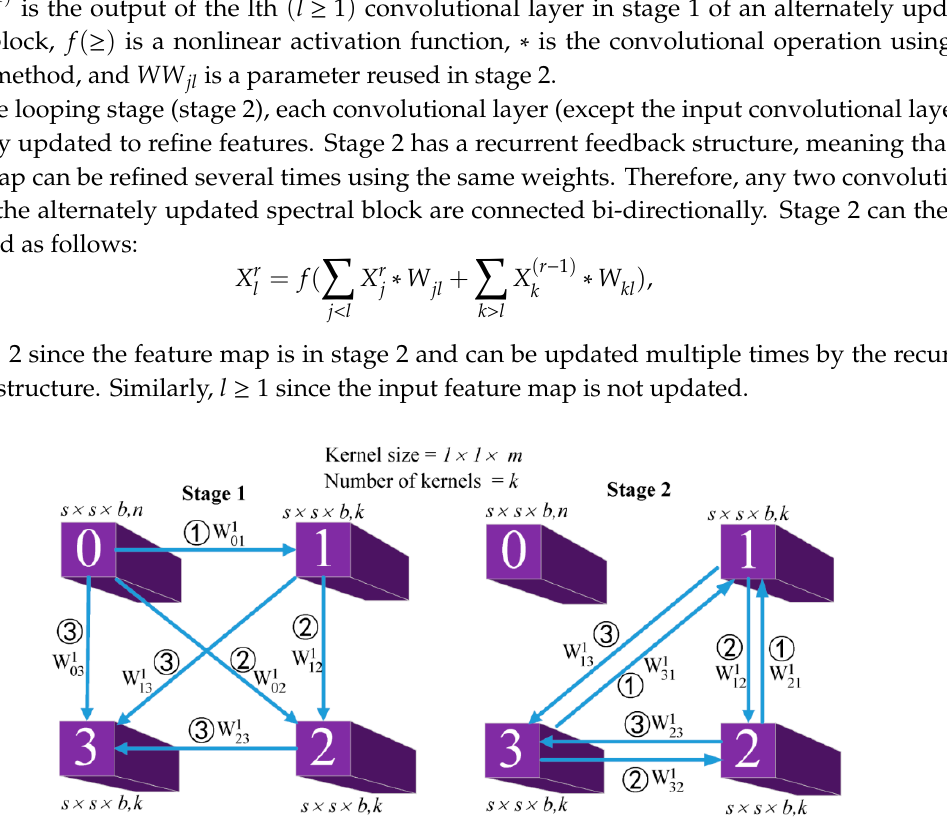
Figure 3. Two stages of alternately updated spectral blocks with three convolutional layers.